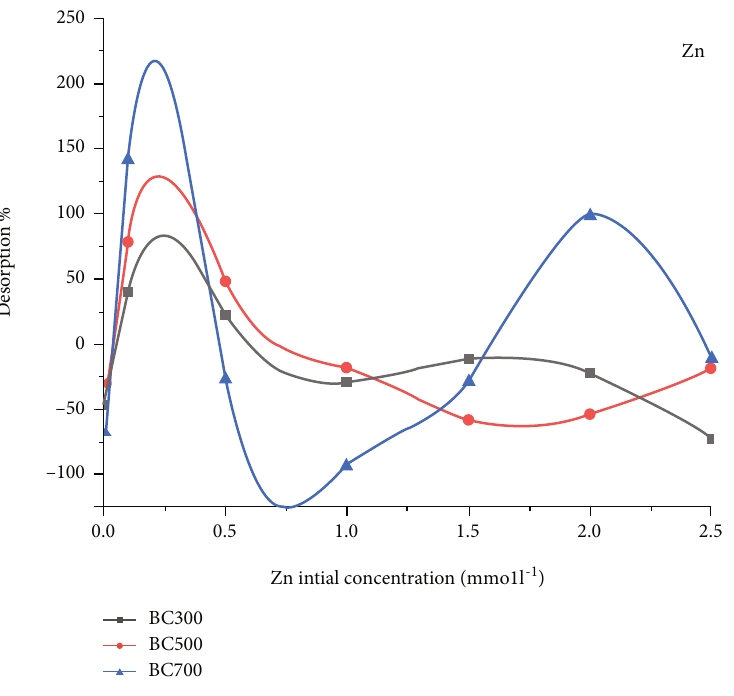
Figure 13: Desorption rate of Zn 2+ in straw with di ff erent concentrations of heavy metal ions. Table 2: Competitive adsorption model of Pb 2+ in acid solution of straw carbon.